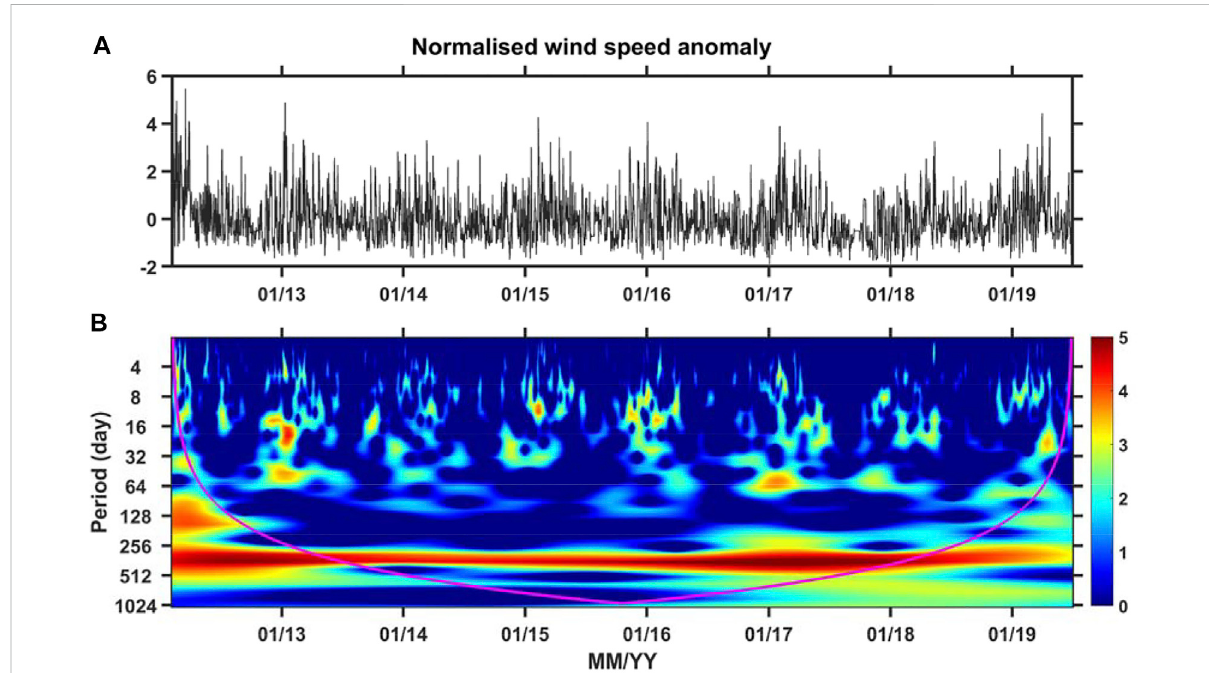
FIGURE 5 (A) Time-seriesofdaily60-mwindspeednormalizedanomalies,obtainedfortheFebruary2012-June2019dailymeanandstandarddeviation, and (B) correspondingwaveletpowerspectrumusingtheMorletwavelet.Thepurplelinedenotesthecone-of-in fl uence,whichgivesthemaximum period of useful information at a particular